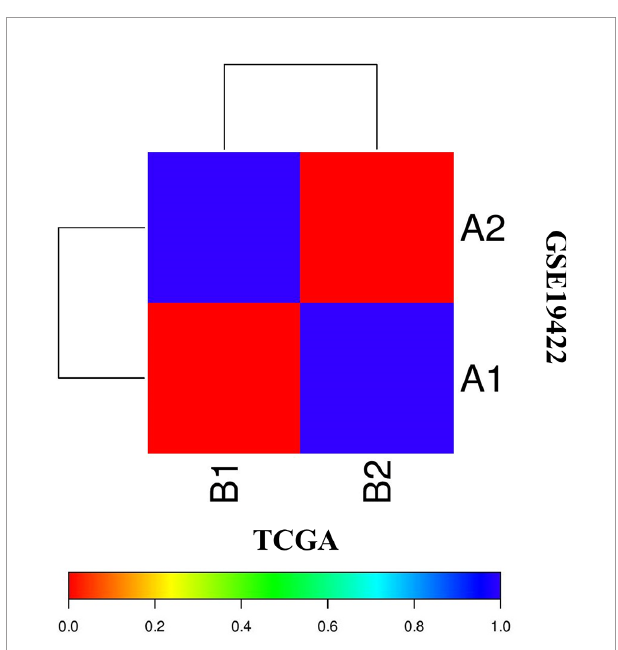
FIGURE 3 | SubMap association between the two molecular subtypes from the two independent datasets of TCGA and GSE19422 presents a signi fi cant correlation. FDR-corrected p-value denoted the correlation signi fi